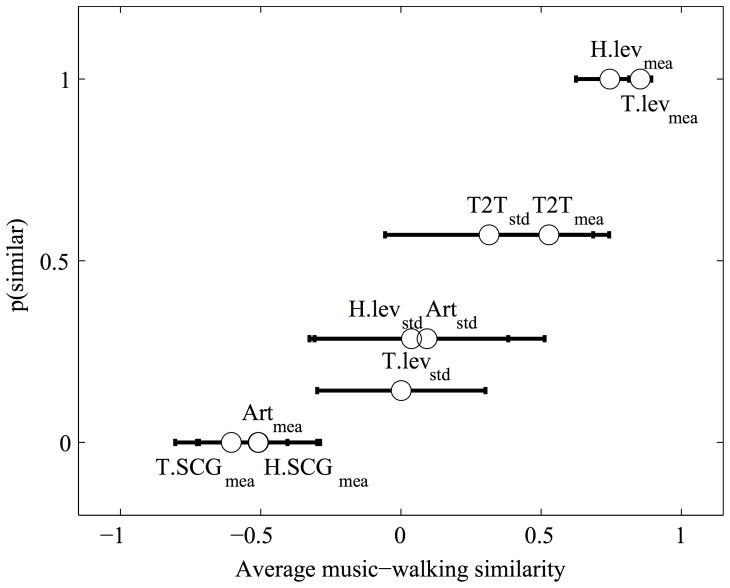
Similarity in the acoustical expression of emotions in music and walking performance.The abscissa shows the similarity scores averaged across walkers (Spearman rank correlation coefficients). The ordinate shows the proportion of walkers for which a higher-than-chance similarity is observed. H = Heel; T = Toe; lev  =  level; SCG  =  Spectral Center of Gravity; Art  =  articulation; mea  =  mean; std  =  standard deviation. Error-bars  =  95% confidence intervals for the average performance.